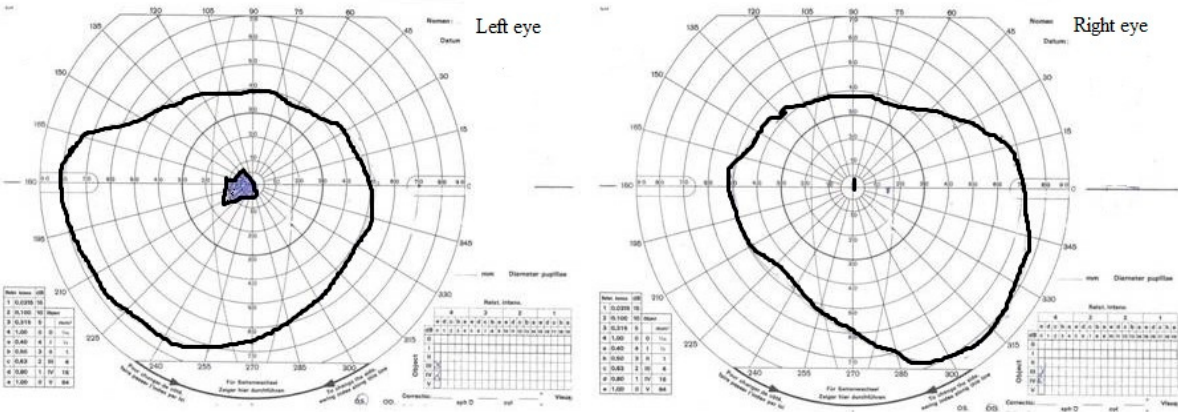
Figure 2. The middle child. Kinetic visual field examination (August). A central scotoma was in the visual field of both the left and right eye.